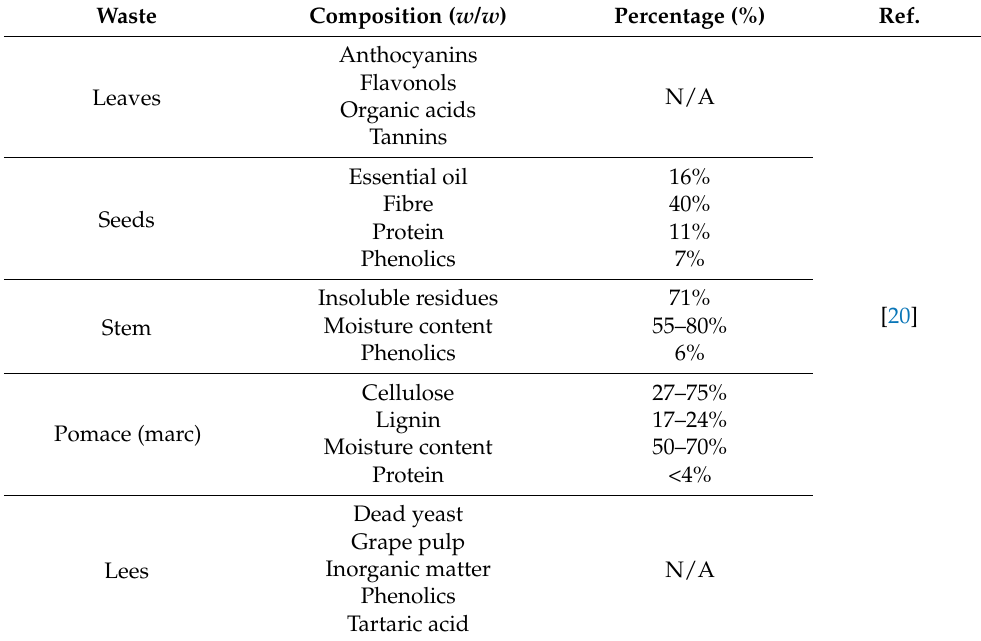
Table 1. Main characteristics of the